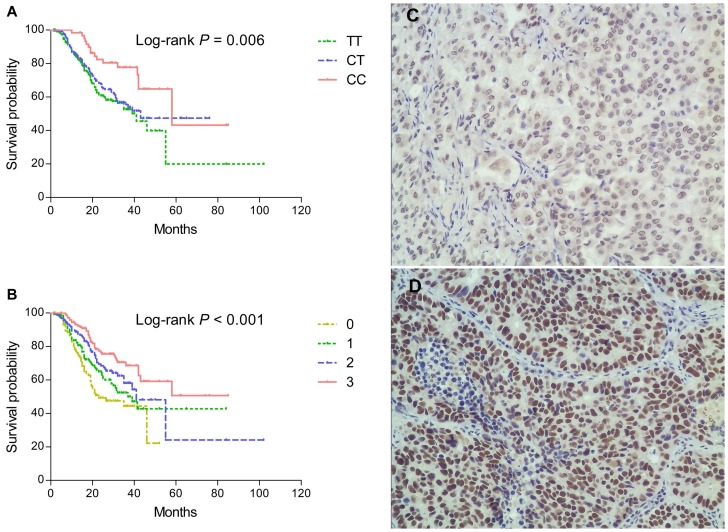
Kaplan-Meier plots of survival by SET8 genotypes in NSCLC patients’ survival and SET8 protein expression levels in NSCLC tissues with immunohistochemistry.(A) SET8 rs16917496 genotype and NSCLC survival (log-rank P = 0.006) in a codominant model. (B) Kaplan-Meier plots of survival by combination of SET8 genotypes and smoking status in NSCLC survival (log-rank P<0.001). 0, patients with common genotype (TT) and ever smoking; 1, those with variant genotypes (CT or CC) and ever smoking; 2, those with common genotype but without smoking; 3, those with variant genotypes and without smoking. (C) low expression; (D) high expression. Cells with a brown-stained nucleus are regarded as positive. Original magnification: ×200. NSCLC, non-small cell lung cancer.